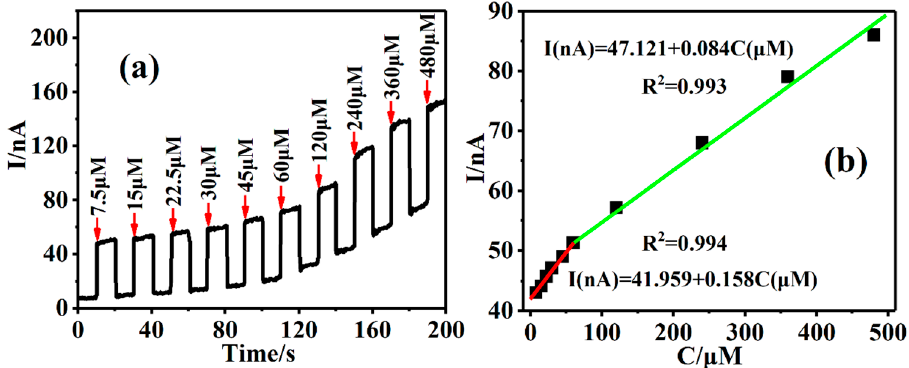
Figure 9. ( a ) Amperometric I-t curve of Cu-TCPP@MOFs/GCE in different concentrations of AA solution in 0.1 M PBS (pH = 7) at a regular time interval of 10 s (applied potential was 0.1 V) by PEC detection. ( b ) The standard curves of the peak currents versus different concentrations of AA